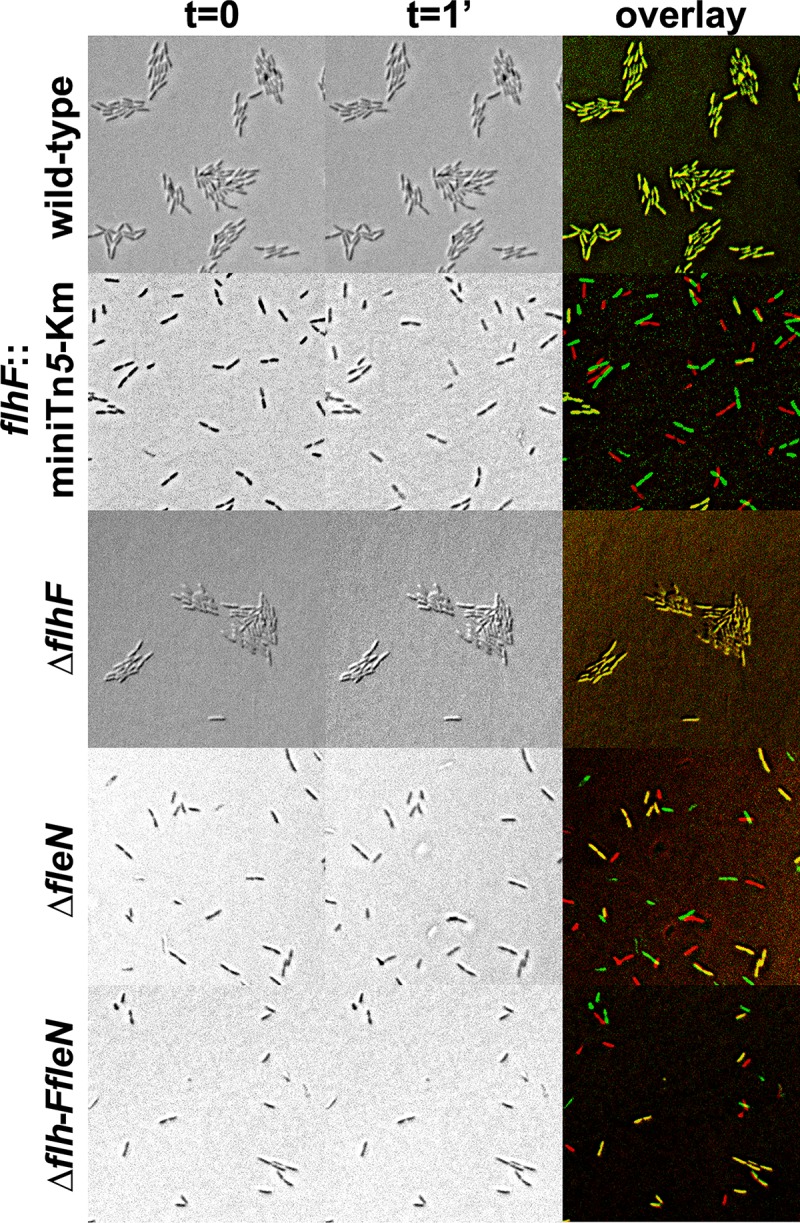
Microscopy adhesion assay of flhF and fleN mutants.Phase-contrast micrographs of (from top to bottom) the wild-type strain KT2442, the flhF:miniTn5-km mutant MRB49, the ΔflhF mutant MRB69, the ΔfleN mutant MRB71 and the ΔflhF-fleN mutant MRB78. Two frames of the same field were taken in a 1-minute interval (left and center). The right panel shows an overlay of the two images of each strain digitally colored red (t = 0) or green (t = 1 min).